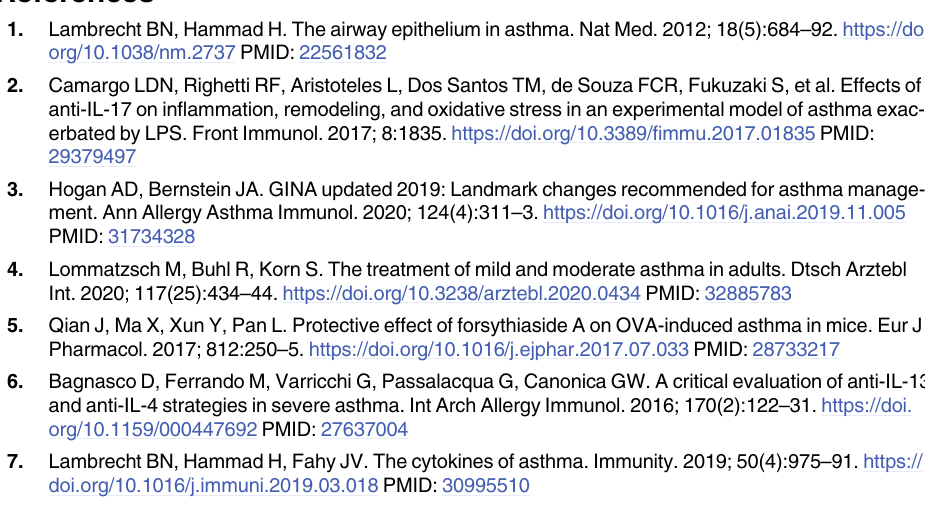
were exposed to methacholine (4, 8, 16 mg/ml). After methacholine exposure, the tidal volume of the lungs was measured by plethysmography. Data are expressed as mean ± SEM. Statistical analysis was performed using the Student’s t -test, one-way ANOVA, and two-way ANOVA. OVA, ovalbumin; IBMX, 3-isobutyl-1-methylxanthine; Vinp, vinpocetine; Dex, dexametha- sone. (TIF) S2 Fig. The release of IL-4 and IL-5 in BALF. ( A ) and ( B ) The release of IL-4 and IL-5 in BALF was measured by ELISA. Data are expressed as mean ± SEM. Statistical analysis was per- formed using one-way ANOVA. BALF, broncho-alveolar lavage fluid; OVA, ovalbumin; Vinp, vinpocetine; Dex, dexamethasone. (TIF) S1 Raw images. Uncropped western blot data.